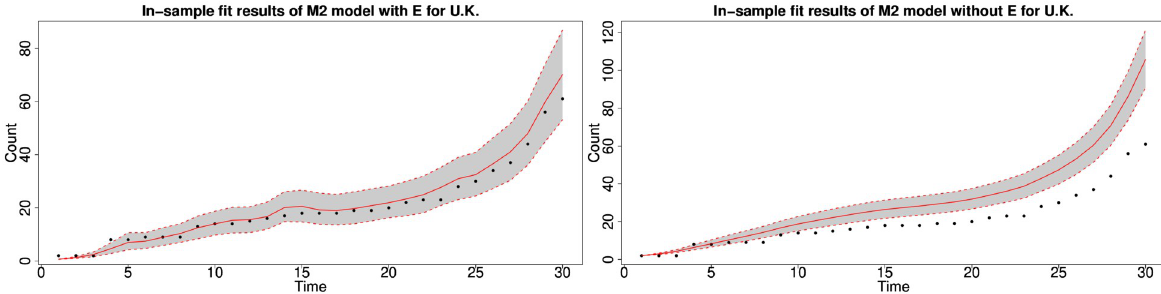
Fig 19. In-sample fit results with the sentiment exposure adjustment for the United Kingdom. In-sample fitting plot for the UK by Model 2 for the first month with (left) and without (right) the sentiment exposure adjustment.